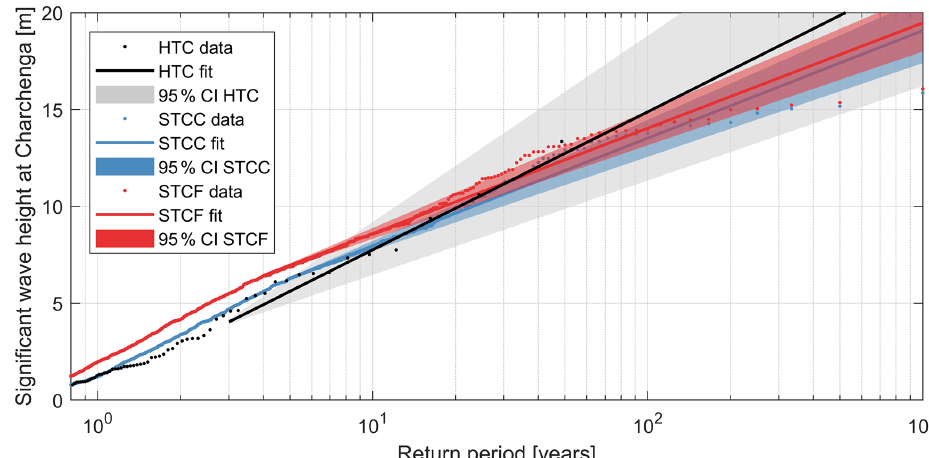
Figure B5. Example of an extreme values analysis for significant wave height at Charchenga, Bangladesh, for HTCs (black), STCC (blue) and STCF (red). The horizontal axis represents the return period on a logarithmic scale, while the vertical axis represents the significant wave height in meters. Shown are the data points with respective return periods (dots), the EVA fit (solid line) and the 95% confidence intervals (colored fills).